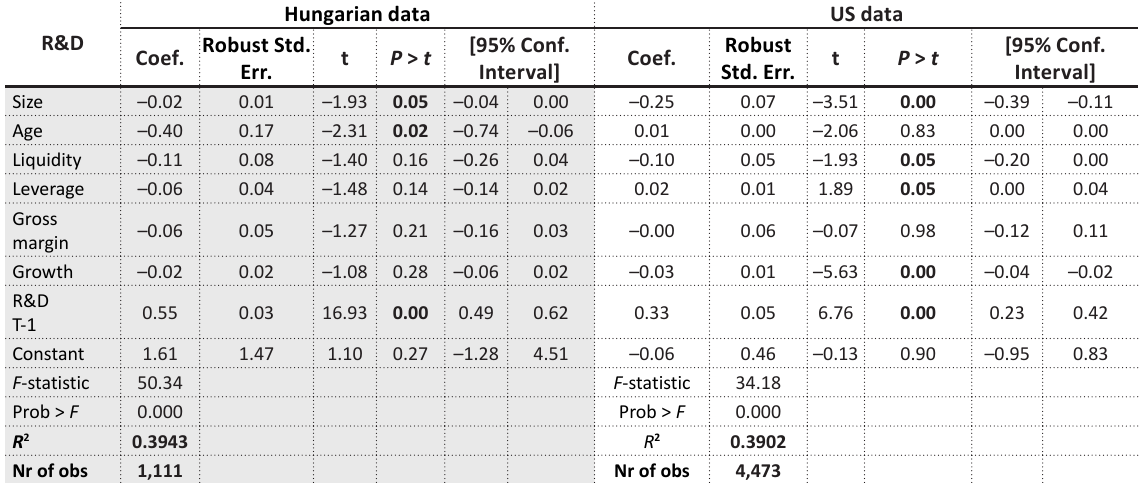
Table 8. Results of the fixed effect panel regression, 3rd model, dependent variable: R&D Hungarian data US data R&D